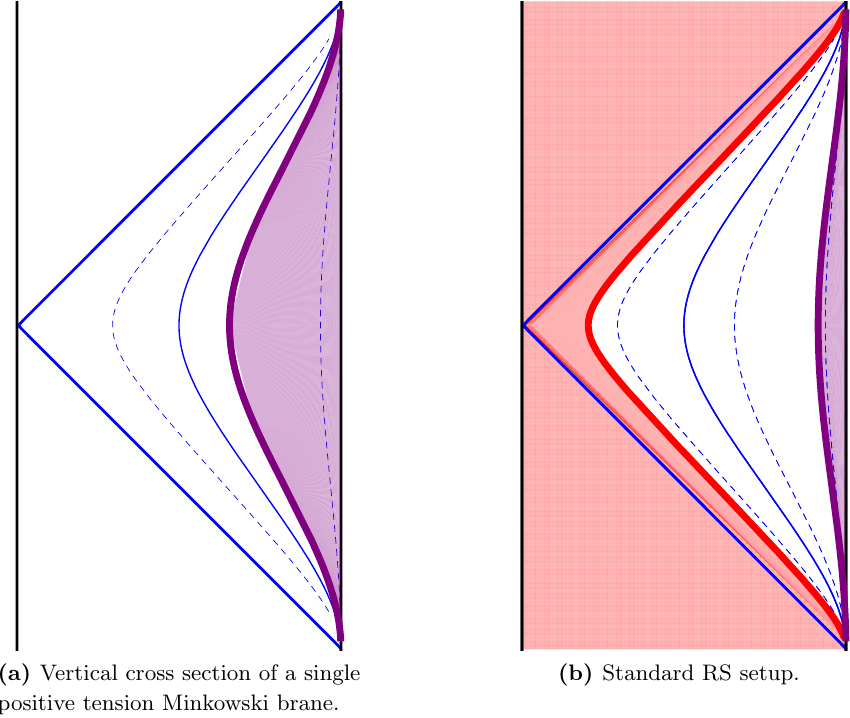
Figure 1. Vertical cross section of branes in Minkowski